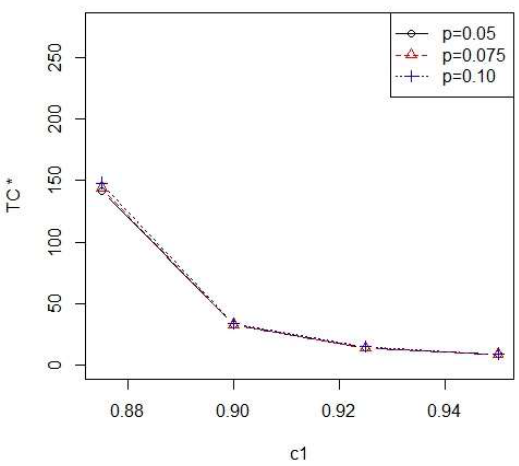
Figure 4. Minimum total cost curve for 1 − β = 0.75, 0.80, 0.85 at α = 0.1 and p = 0.05.